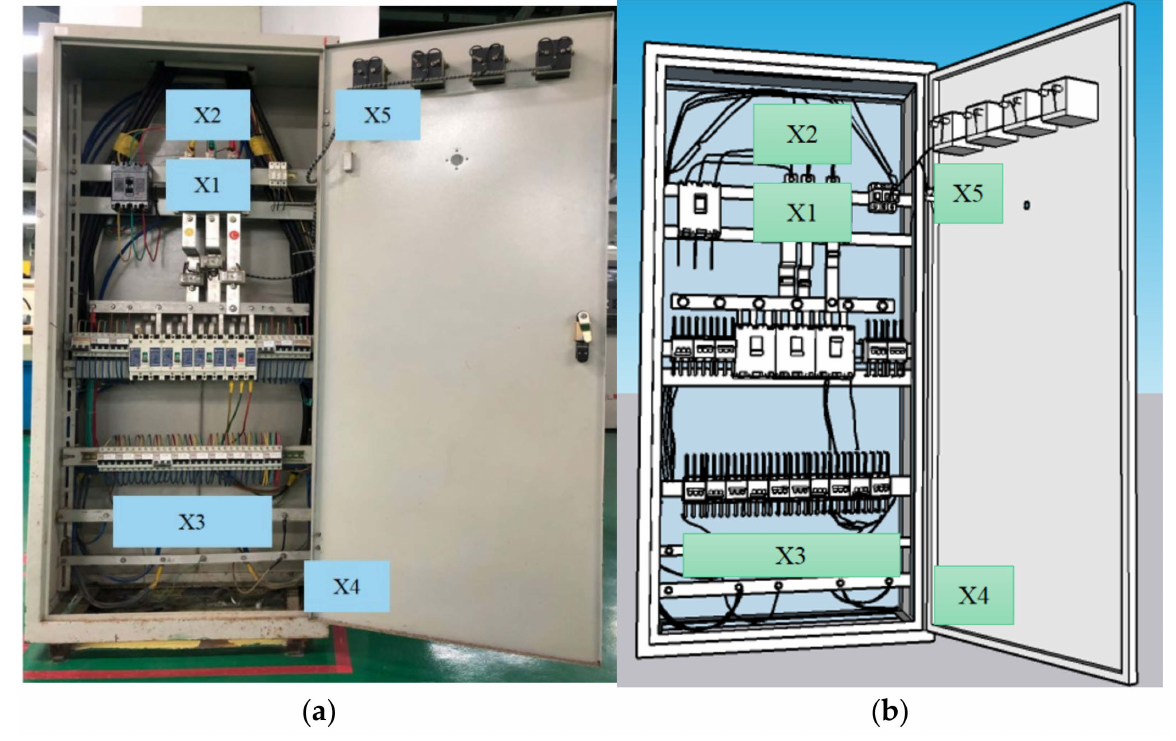
Figure 2. Hazard distribution area. ( a ) real scene, ( b ) image test. Compare the above two experimental data; the results are shown in Table 2. Table 2. Comparison of Test Methods for Hazard Perception of Electrical